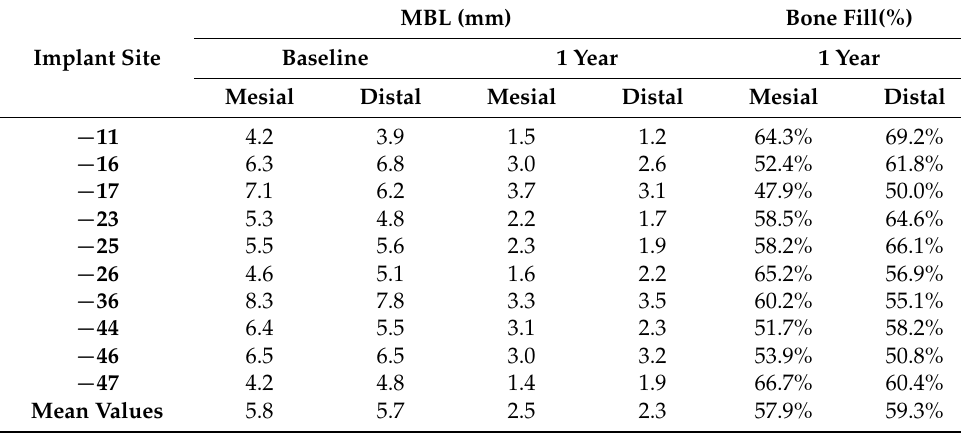
Table 2. Marginal bone level (MBL) and bone fill